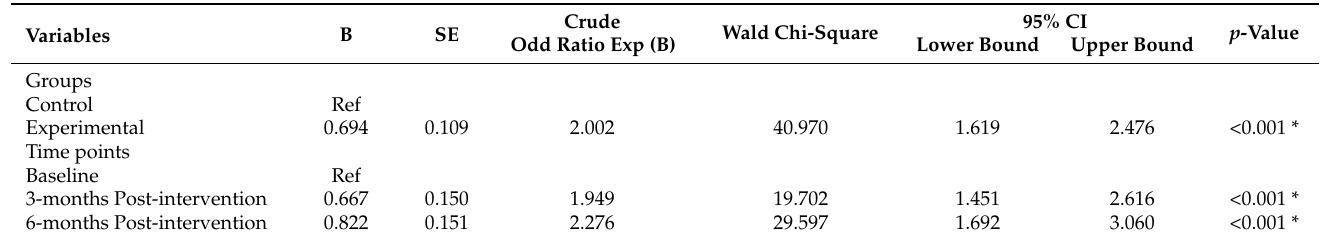
Table 6. Comparison of Attitude towards Malnutrition between Groups and Time Points (baseline to three and six-months post-intervention) respectively using